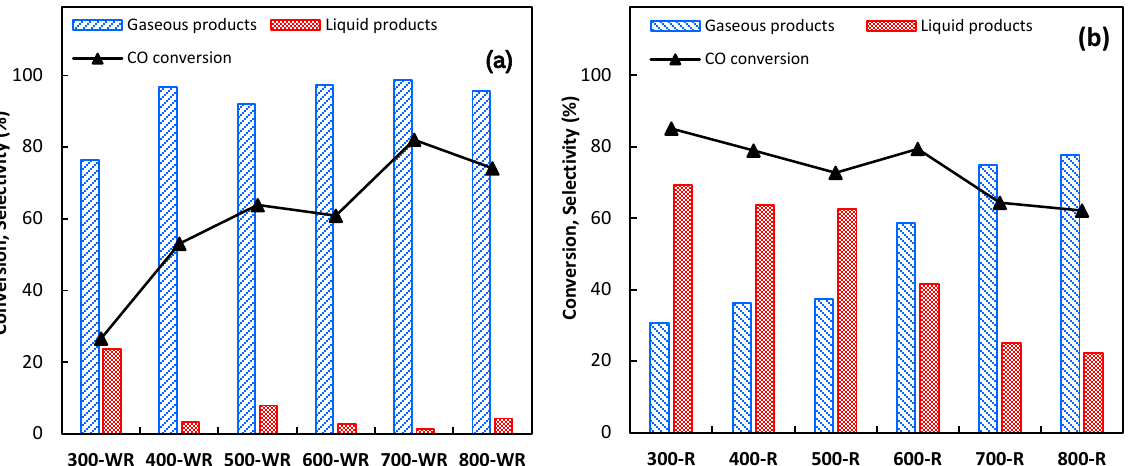
Figure 5. The gaseous and liquid product distributions after FT reaction at 230 °C and 6 h of reaction ( a ) without reduction with H 2 , ( b ) reduced with H 2 (WR: without reduction step, R: with reduction step).